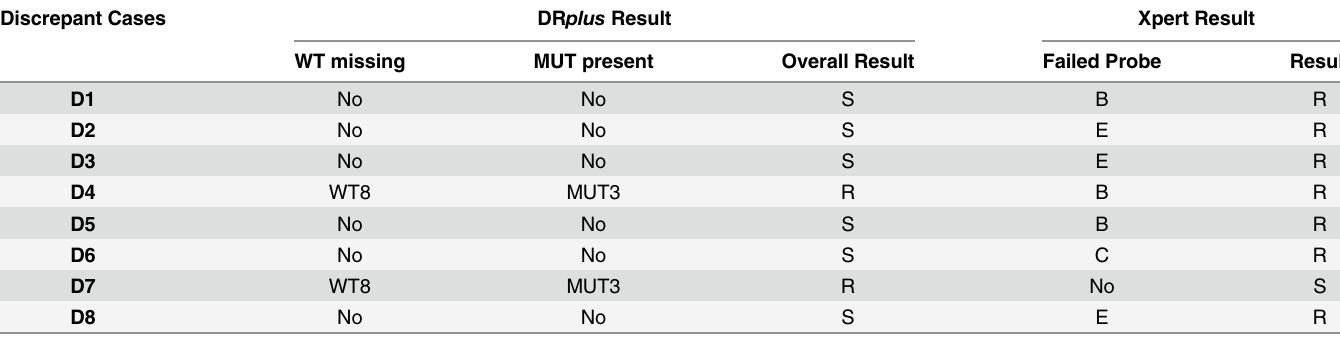
Table 4. Drug susceptibility result of 8 discrepant cases between two molecular DST methods. Discrepant